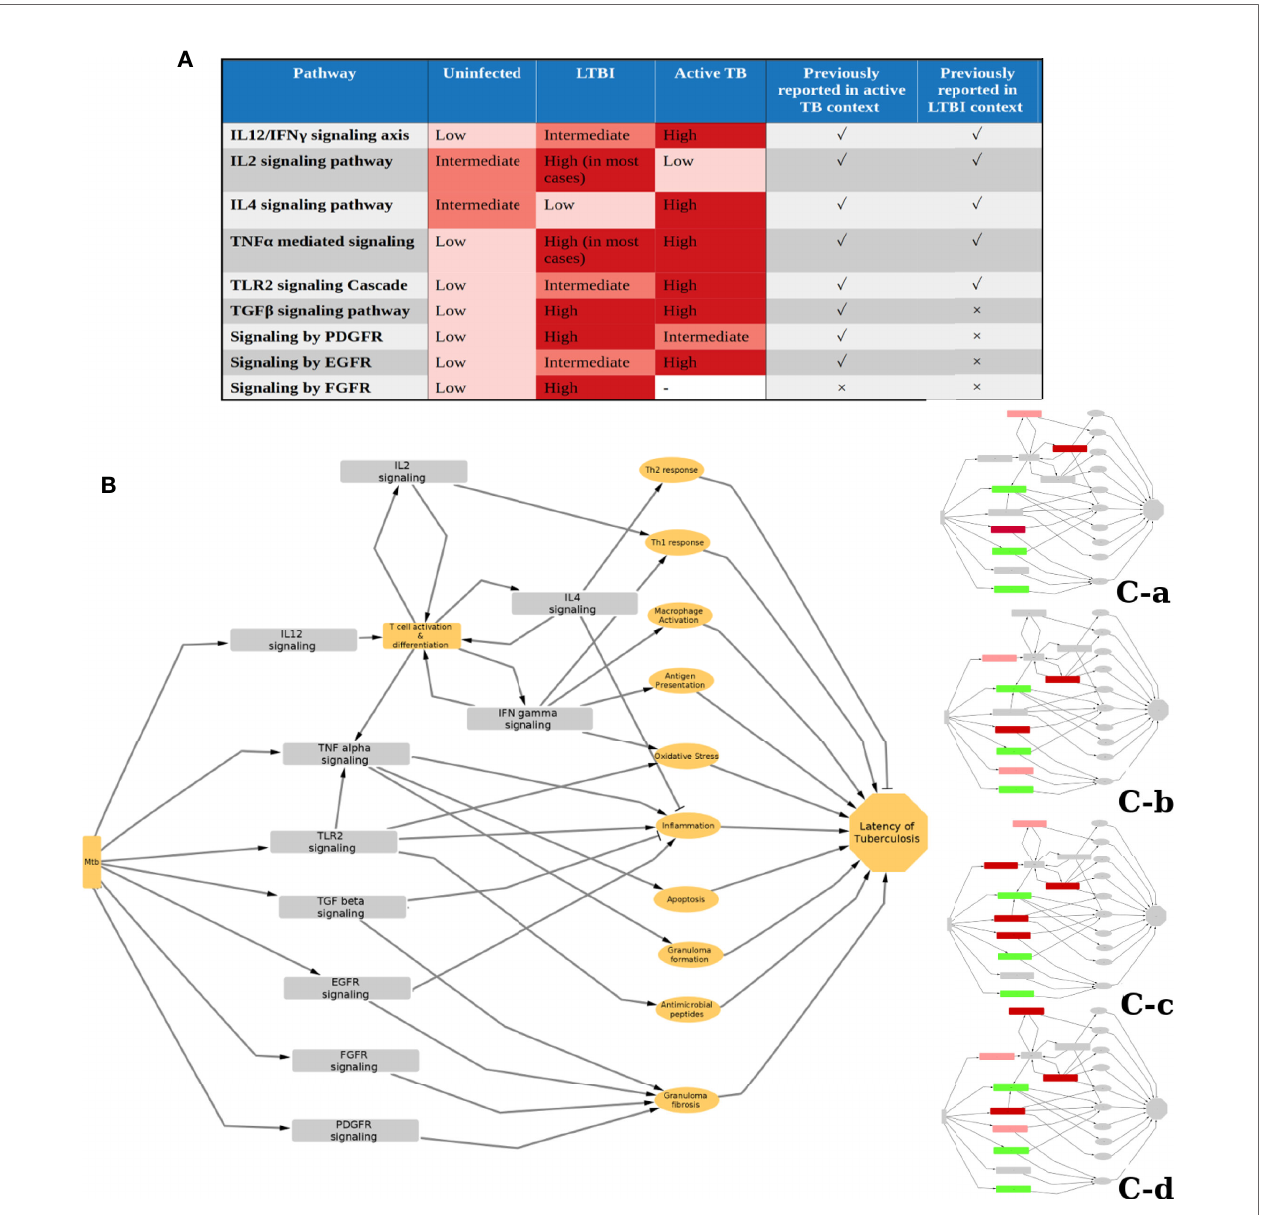
FIGURE 6 | Status and function of IPLTB in uninfected (HC), LTBI and active TB patients. (A) The extent of activity of the IPLTB pathways is active TB condition compared to HC and LTBI was analyzed using a similar network analysis method. From this analysis, as well as literature reports, the status of these pathways in the 3 conditions, HC, LTBI and active TB, are summarized in a semiquantitative manner. IL12/IFN g , TLR2 and EGFR mediated signaling pathways were found to be more active in LTBI compared to HC and further activated in active TB. IL2 and IL4 showed an opposite trend of activity in LTBI and active TB. TGF and TNF were more active in LTBI and active TB compared to uninfected, but the difference between LTBI and active TB cannot be commented upon from our analysis. PDGFR mediated pathway was observed to be more active in both LTBI and active compared to HC, but the extent of activity was higher in LTBI. FGFR mediated signaling was not observed to be one of the top perturbed pathways in active TB condition. The pathways previously reported to have an important function in the context of active and LTBI are marked with a tick, whereas no previous report is marked with a cross. (B) The possible effects of the IPLTB on the host immune system are drawn as a simpli fi ed schematic. The pathways can be linked to in fl ammation, macrophage activation, antimycobacterial effects, granuloma formation and fi brosis, etc., which can fi nally help in maintaining TB latency. The different clusters use some of the pathways from IPLTB, as shown in insets, to achieve TB latency. Red and green correspond to perturbed activities, in comparison to HC. Green denotes the pathways perturbed in all the clusters, whereas red shows pathways perturbed in different clusters. Dark red signi fi es that most of the members of the cluster show the perturbation whereas light red signi fi es about half of the members to show the